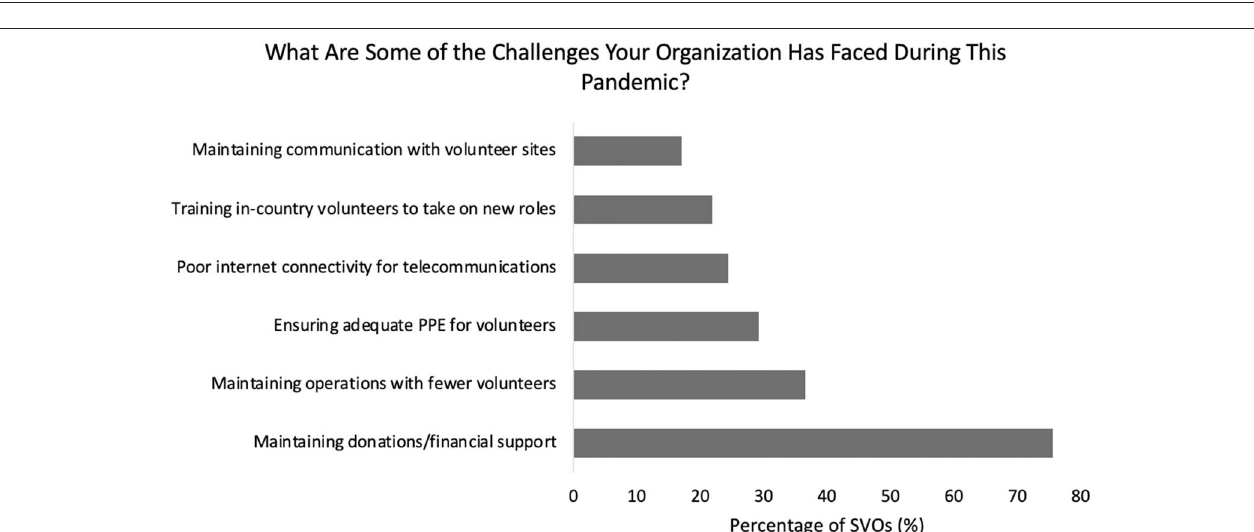
FIGURE 2 | Breakdown of funding reallocation by surgical volunteer organizations during the pandemic.